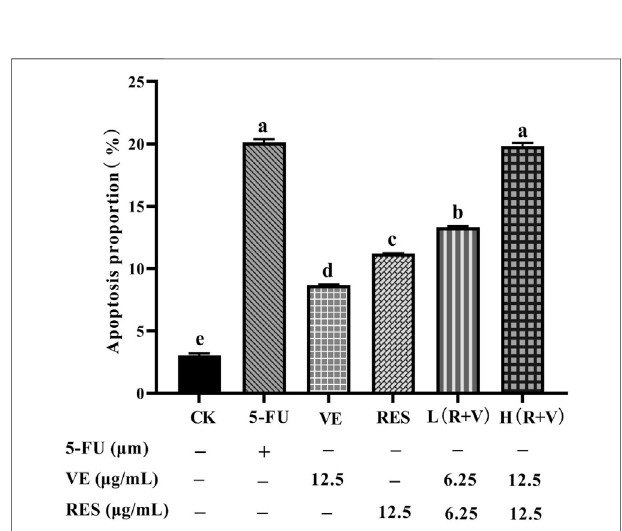
FIGURE 5 | The effect of different treatments on cell apoptosis. Note: a, b, c, d, e represent the statistical results of different groups. Different letters represent statistically signi fi cant differences ( p <